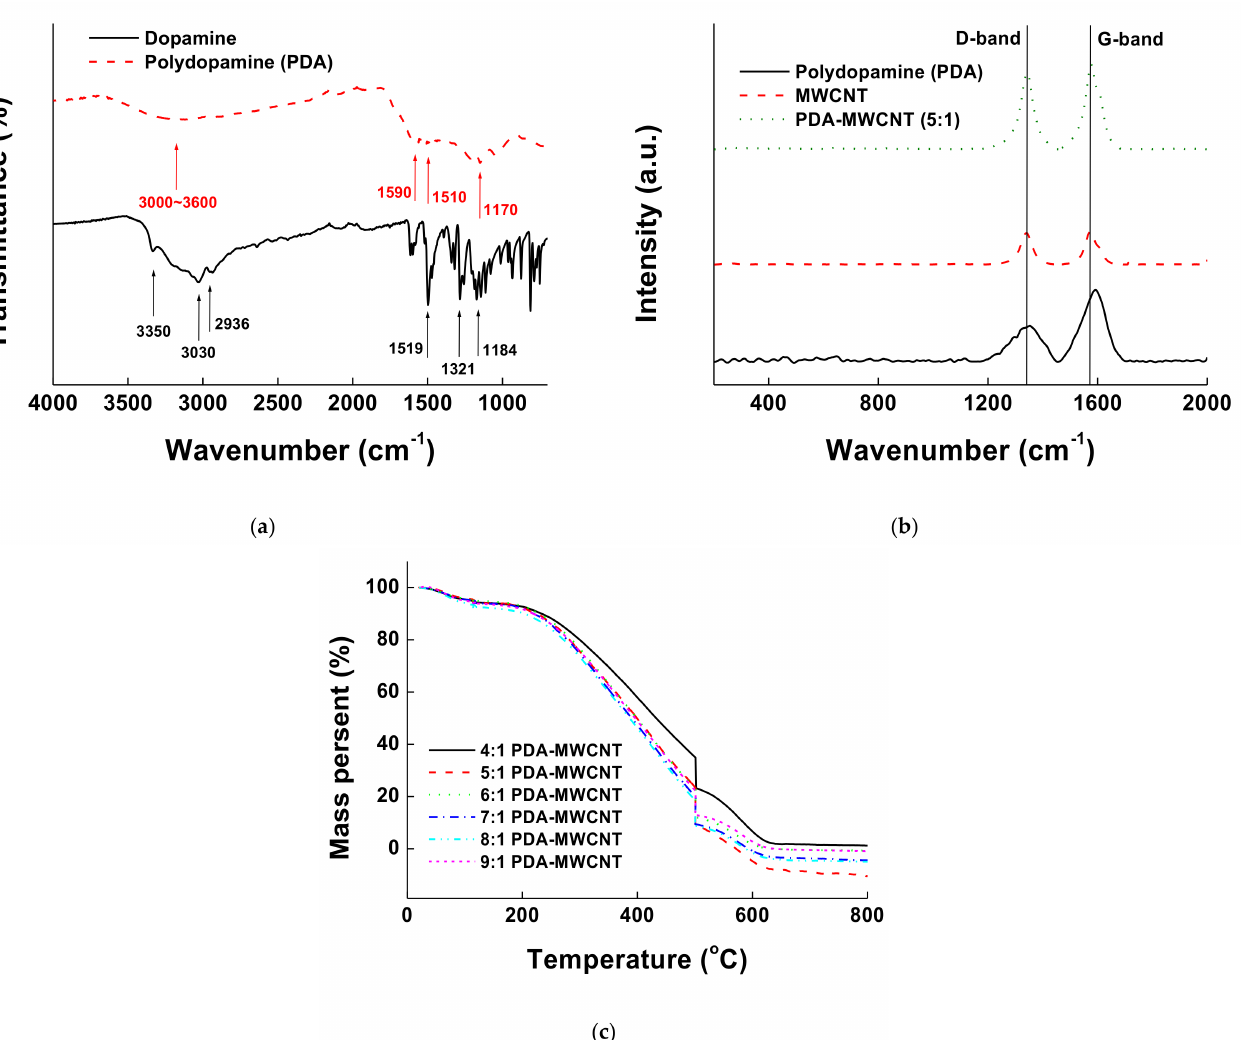
Figure 1. Characterization of PDA and PDA-MWCNT by ( a ) FT-IR, ( b ) Raman, and ( c ) TGA. Secondly, PDA-MWCNT composites were confirmed by the Raman spectrum in Figure 1b. Normally, traditional D and G bands of MWCNT (red line) at 1351 cm − 1 and 1583 cm − 1 , respectively, indicate the preserved graphitic structure. Additionally, PDA- MWCNT composites (green line) synthesized by ultra-sonication for 1 h were